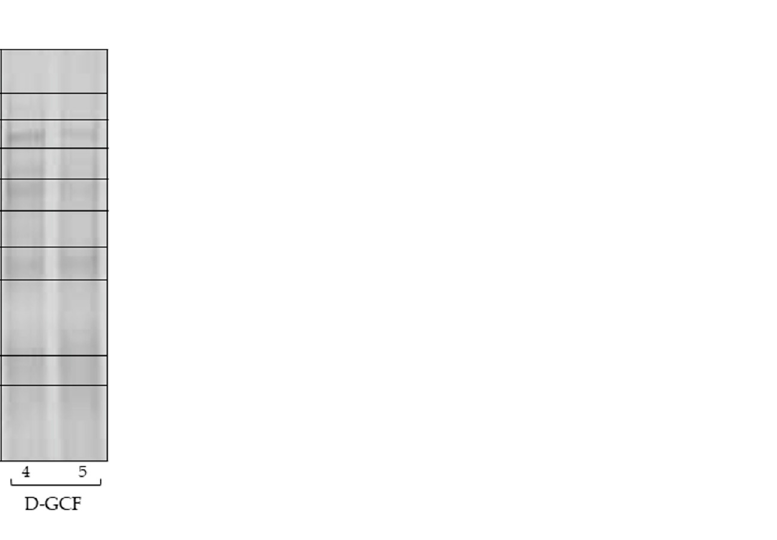
Figure 1. The representative SDS-PAGE image. First lane, MW: molecular weight marker (kDa), Dual Blue Precision Plus Protein Standard. Lanes 2–3, H-GCF: representative pools of H-GCF samples. Lanes 4–5, D-GCF: representative pools of D-GCF samples. The differentially expressed bands are enclosed within lanes. Gel separation: gradient Bolt 4–12% Bis-Tris Plus, Coomassie Blue stain method.